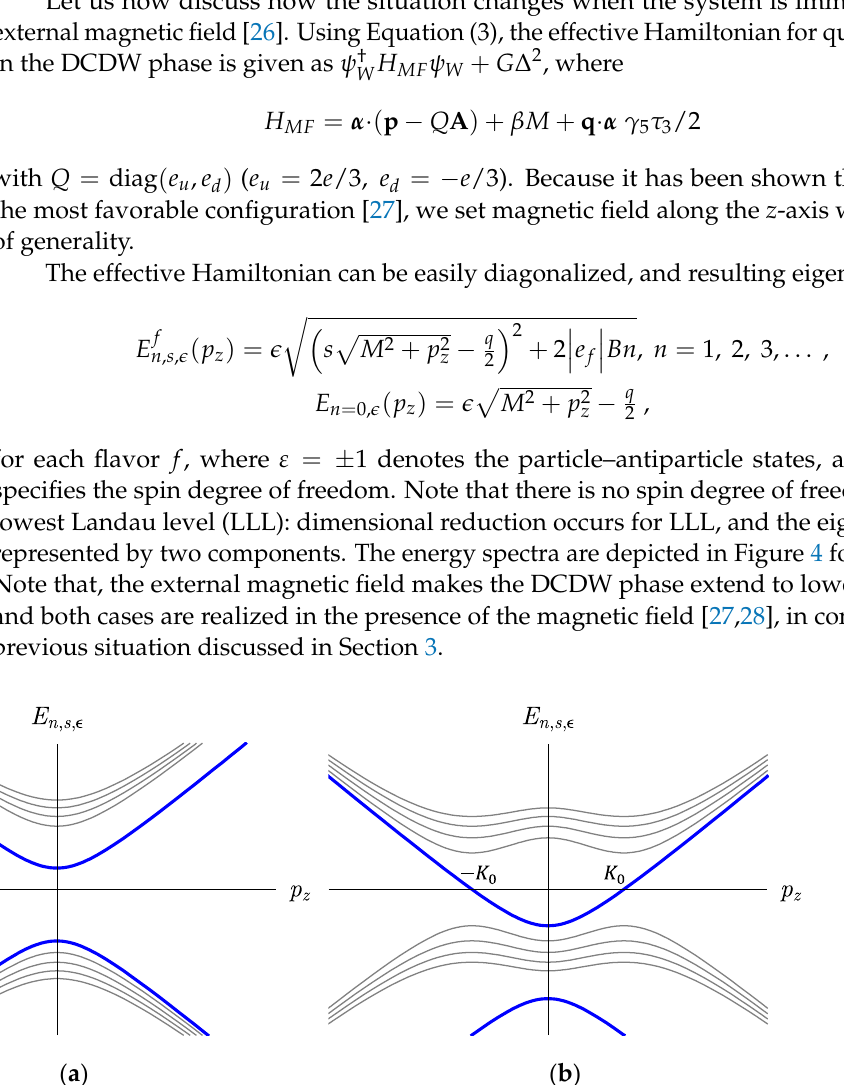
, while right panel ( b ) is for 2 . Lowest Landau level (LLL) for each (cid:2870)